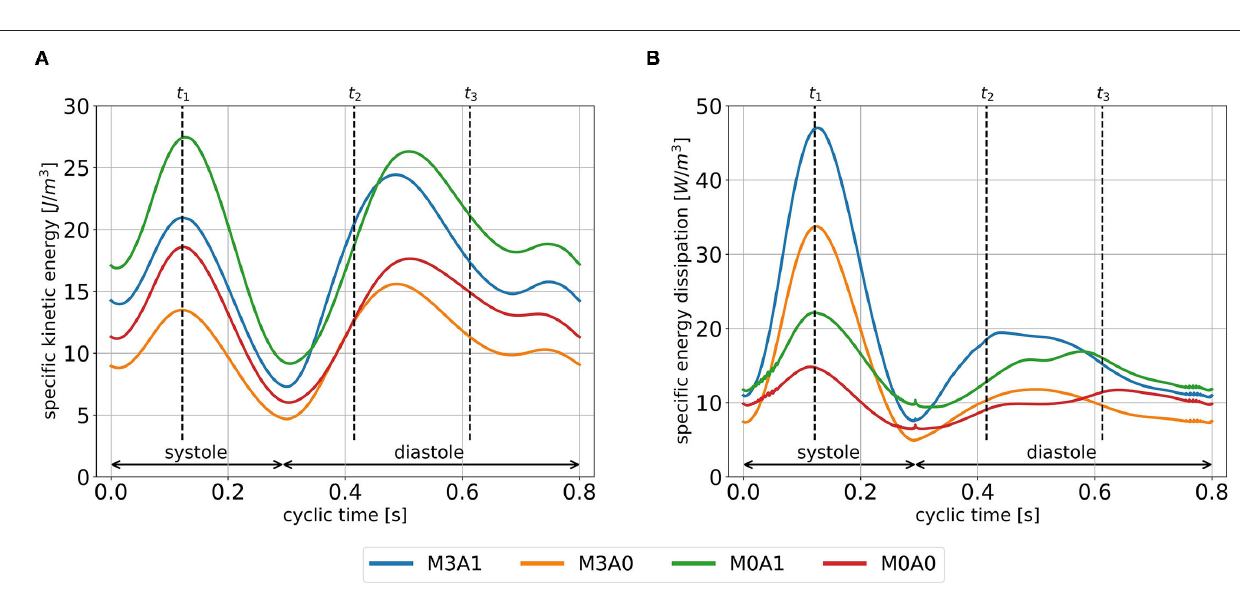
ejection evolutes in a staircase-like manner with reducing stair sizes. Characteristic washout measures are displayed in Table 4 . The 99 % washout is computed via the exponential fit function in Equation (8). The R 2 values (quality criterion for regression models) for the exponential fits are above 97 % for all cases. Figure 9B . Cases M3A1, M0A1, and M0A0 behave similar in a